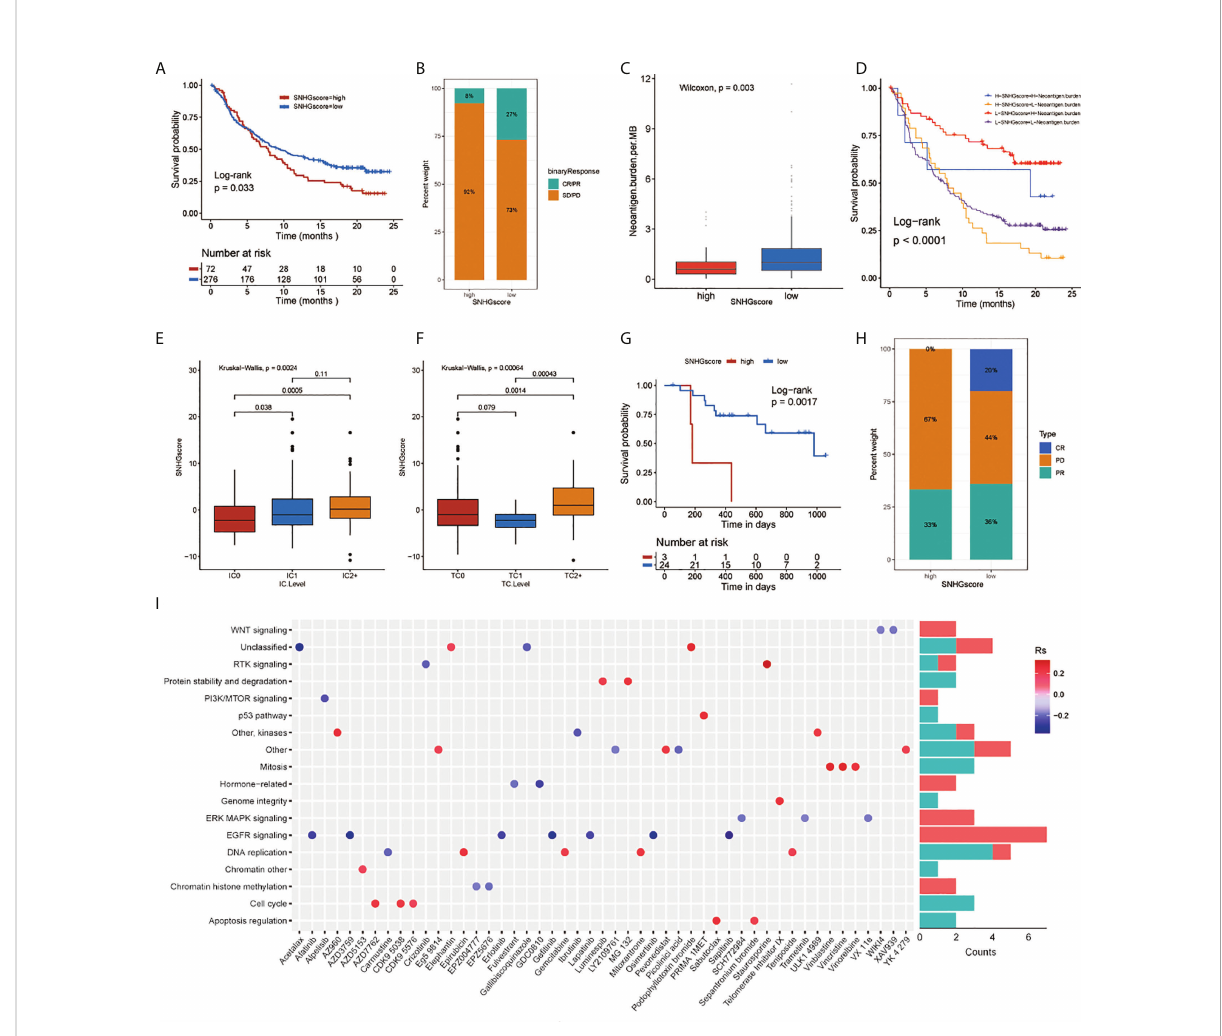
FIGURE 5 The relationship between SNHGscore and immunotherapy response and drug sensitivity. (A) Survival analyses for high and low SNHGscore patients in anti-PD-L1 immunotherapy cohort (P = 0.033). (B) Proportion of patients in the high or low SNHGscore group who responded to PD-L1 blockade immunotherapy. (C) Differences in neoantigen burden expression between high and low SNHGscore groups. (p = 0.003). (D) Survival analyses for patients receiving anti-PD-L1 immunotherapy strati fi ed by both SNHGscore and neoantigen burden (P< 0.0001). (E, F) Differences in SNHGscore among three IC levels (E) and three TC levels (F) , respectively. (G) Survival analysis for high and low SNHGscore patient groups in the anti-PD1 immunotherapy cohort (GSE78220 cohort; P = 0.0017). (H) Proportion of patients in the high or low SNHGscore group who responded to PD-1 blockade immunotherapy. (I) Drug-targeted signaling pathways that are resistant or sensitive to